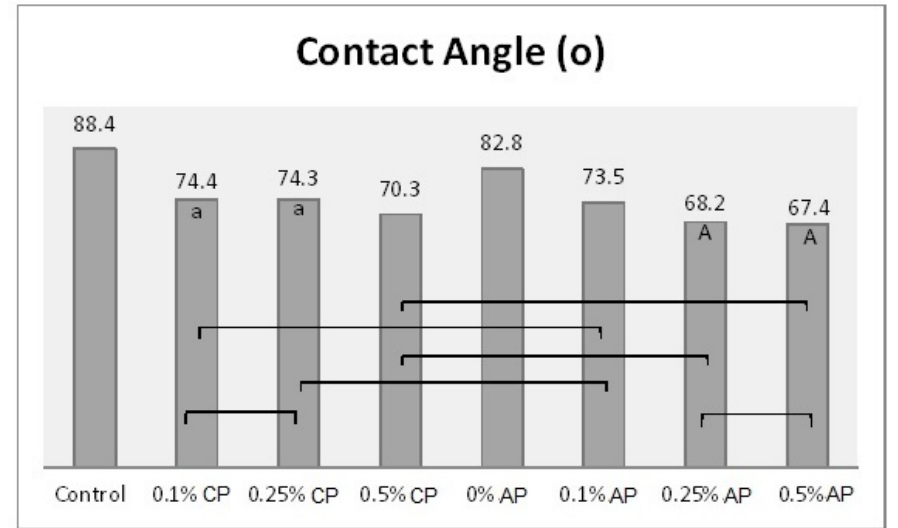
Figure 4. Mean of contact angle ( o ) and significances between groups for ND concentrations and polymerization techniques. Same lower-case letters a show insignificant differences in means within CP group. Same capital letters A show insignificant differences in means within AP group. Lines show the insignificant differences between all groups comparing polymerization techniques.